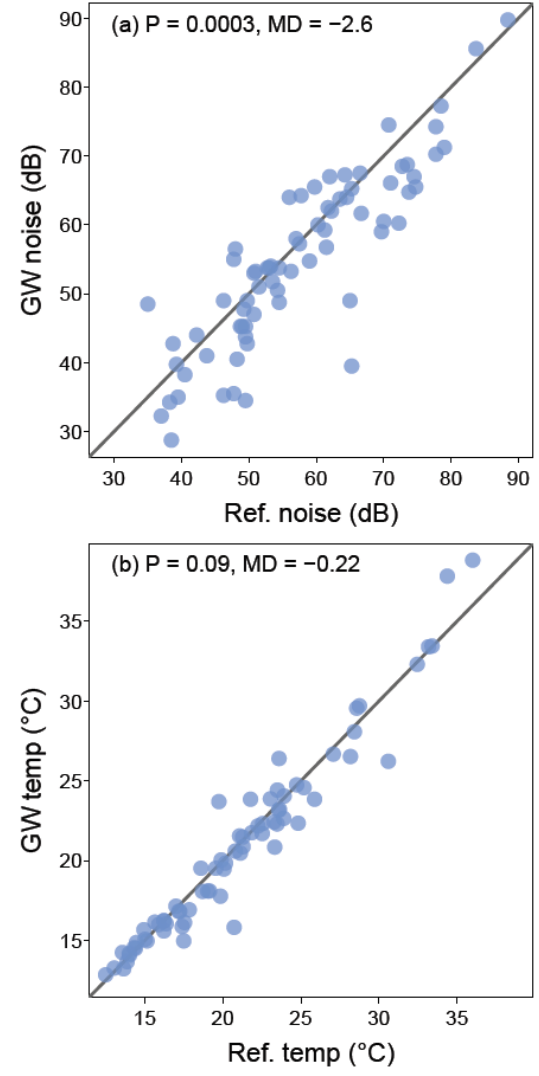
Figure 5. Scatter plots showing noise ( a ), and temperature ( b ) at the green wall ( y -axis) and reference wall ( x -axis). Black lines represent a 1:1 relationship, therefore all points falling below the line indicate lower values at the green wall relative to the reference wall, and the converse for points above the line. In both plots, p -values (paired t -test) and the mean di ff erence (MD, green wall value—reference wall value) between paired samples in shown.